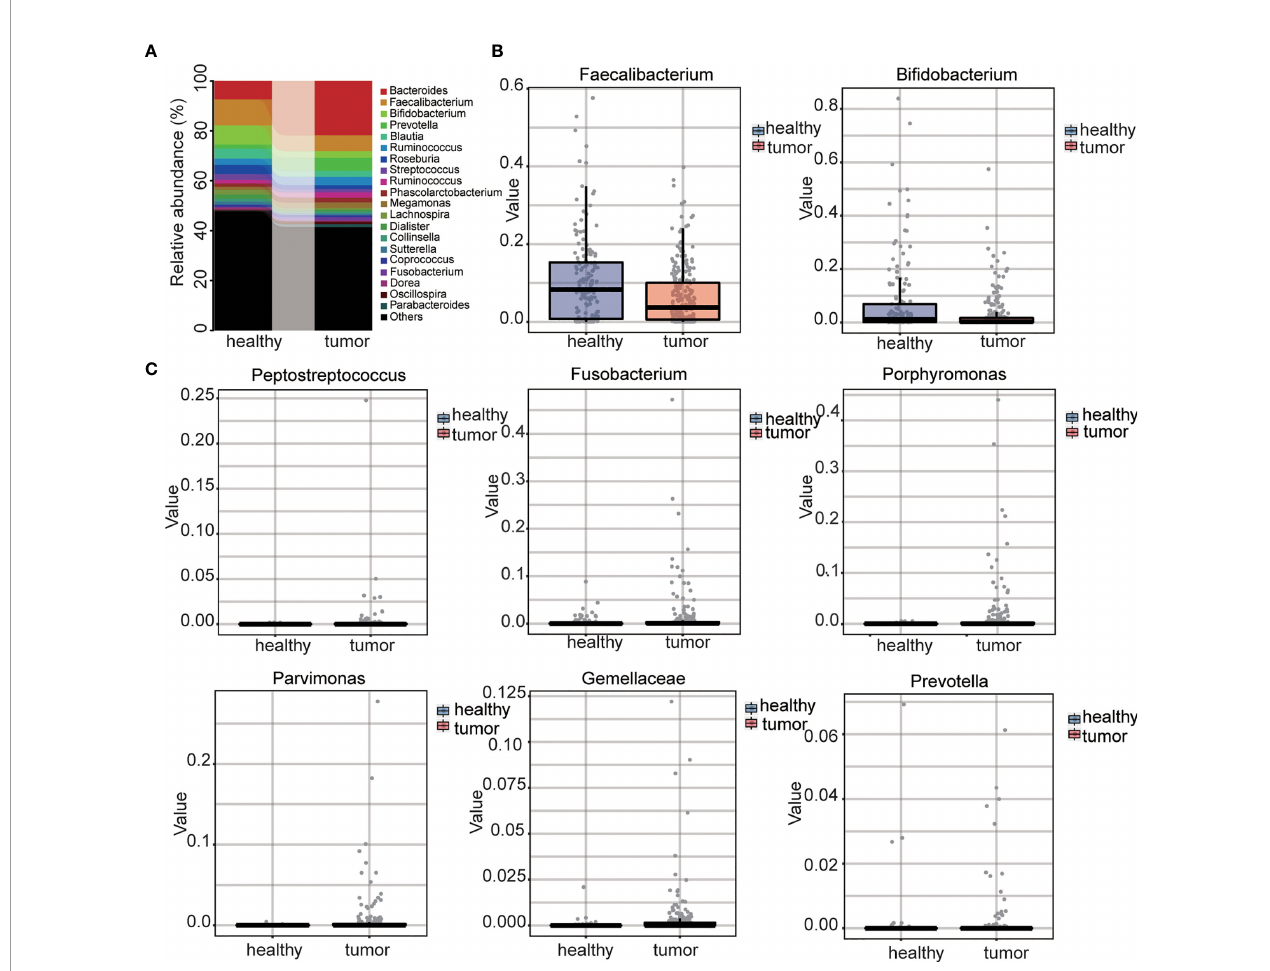
FIGURE 3 | Analysis of genus level and selected genus between CRC and control. (A) The distribution of two groups at genus level. (B) Abundance of bene fi t intestinal bacteria between two groups. (C) Abundance of CRC related intestinal bacteria between two